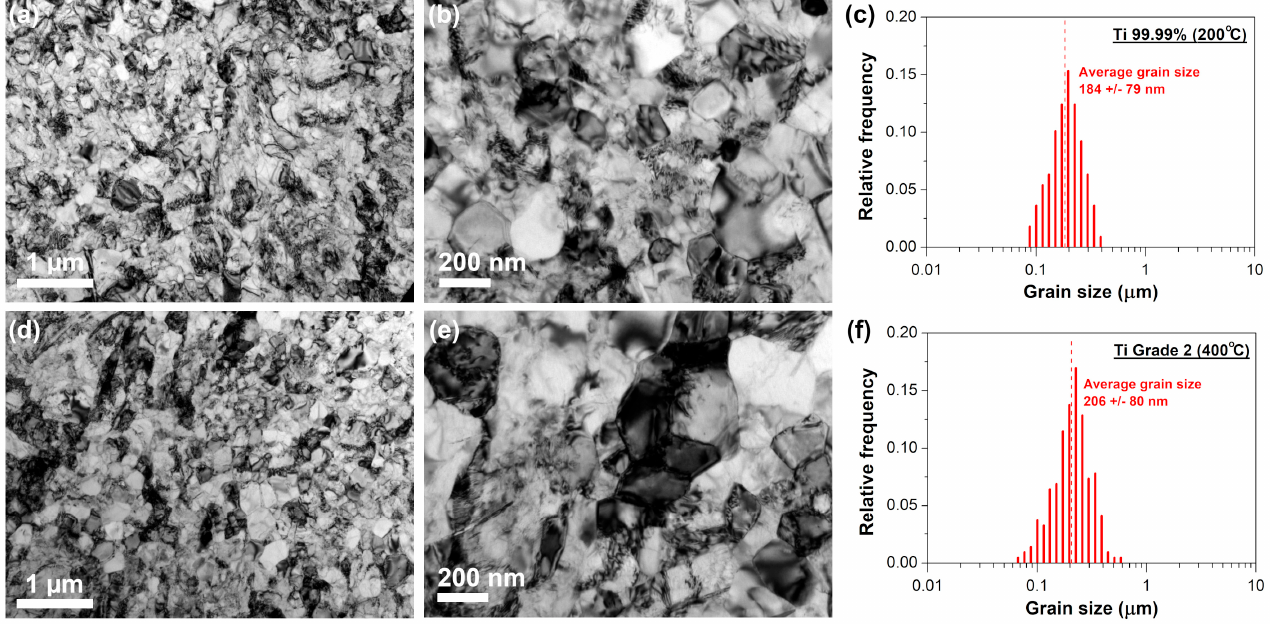
Figure 3. Microstructure of the annealed sheets: ( a , b ) Ti 99.99% at 200 °C and ( d , e ) Ti Grade 2 at 400 °C with the corresponding grain size distributions ( c , f ).